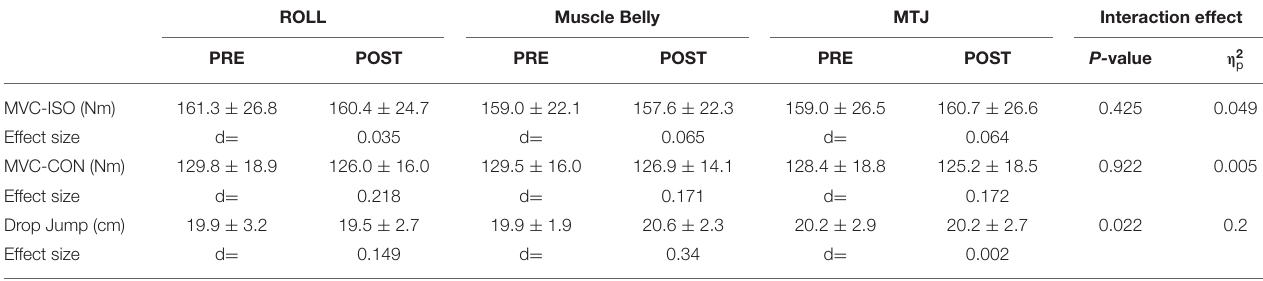
TABLE 2 | Changes in maximal voluntary isometric contraction torque (MVC-ISO), concentric torque at 30 ◦ /s (MVC-CON), and single-leg drop jump height before (PRE) and immediately after vibration rolling (ROLL) or vibration on the muscle belly (Muscle Belly) or vibration on muscle-tendon junction (MTJ) intervention (POST). ROLL Muscle Belly MTJ Interaction effect PRE POST PRE POST PRE POST P- value η 2